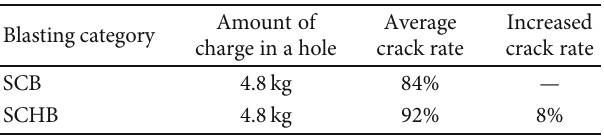
Table 5: Comparison of crack rate between SCB and SCHB.